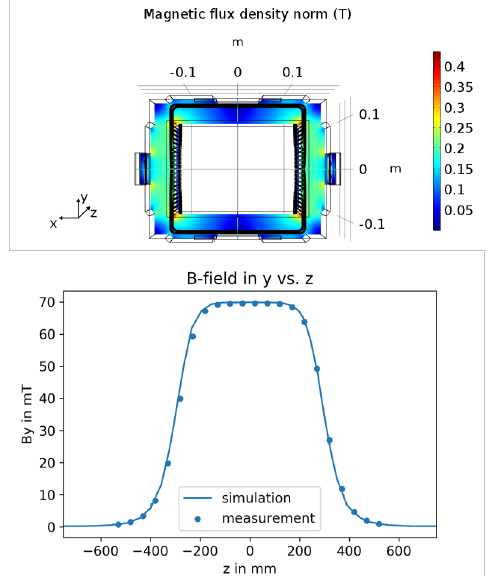
Figure 10. The top graph shows the 2D geometry of the new three-field-septum magnet used in the FEM simulation. The beam is normal to the image plane. The areas comprising gray arrows indicate the permanent magnets and their orientation of magnetization. All other enclosed areas which are mounted on the permanent magnets represent the iron yoke, i.e. carbon steel. The large centered area shows unoccupied space for the vacuum chamber including the three beam spots. The measured beam size at this position is 40mm. The red line shows the segment which was used for the data in the lower graph. This plot shows the magnetic flux density y-component and its gradient versus x